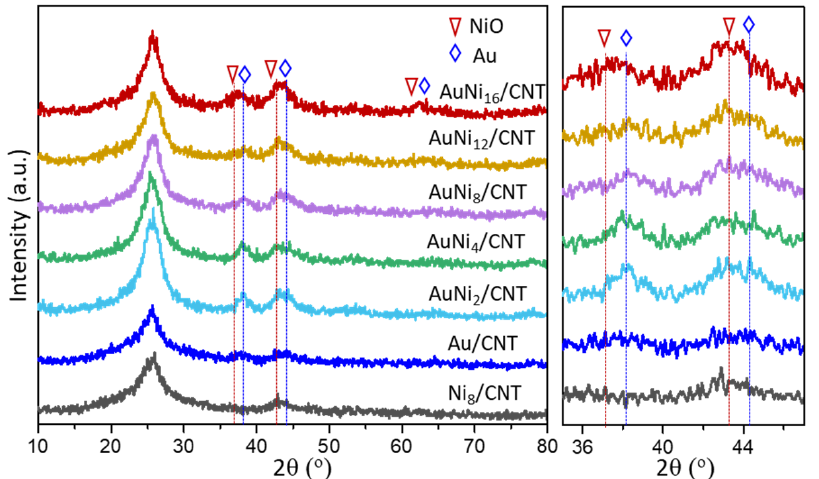
Figure 3. XRD patterns of different AuNi x /CNT samples.